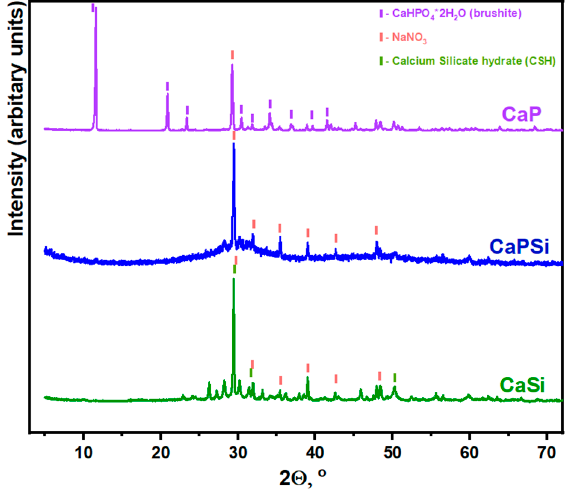
Figure 1. XRD data of powders after synthesis and disaggregation in acetone (CaP, CaPSi, and CaSi). (PDF card 9-77)—brushite, (PDF card 36-1474)—sodium nitrate, (PDF card 33-306)—calcium silicate